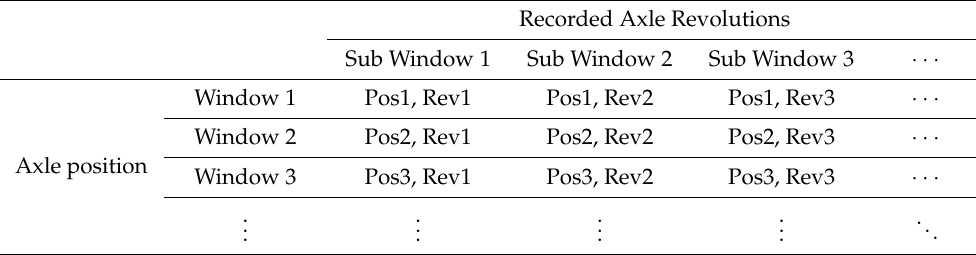
Figure 3. An example of the x [ n ] vector, sampled at f s = 2 MHz for a total length of l signal = 10 f s readings. Pulses repeating themselves at the fault frequency f fault = 1/ rev are visible as peaks in x [ n ] . Table 1. Interpretation of the window function.